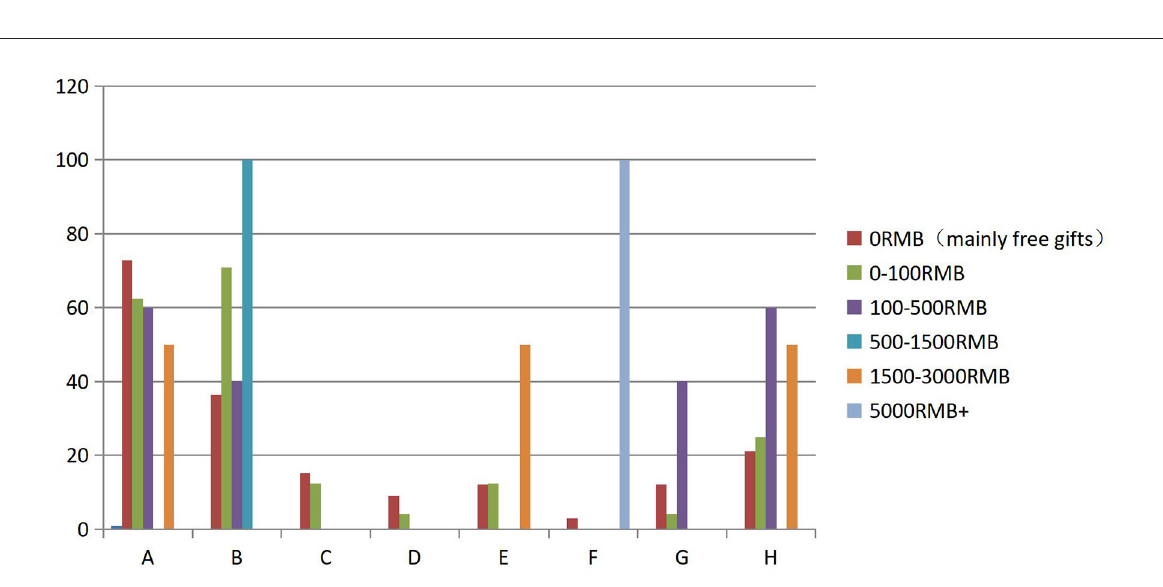
FIGURE2 Cross summary table. (A) Someone who is Talented. (B) Someone who is authentic. (C) Someone who is sophisticated. (D) Someone who is distant. (E) Someone I admire. (F) Someone who understand me. (G) Someone who is the person I want to meet in person. (H) Someone who is my friend Blue bar is prevalence rates, red bar is response rates (see Table 2 in the Appendix for specific